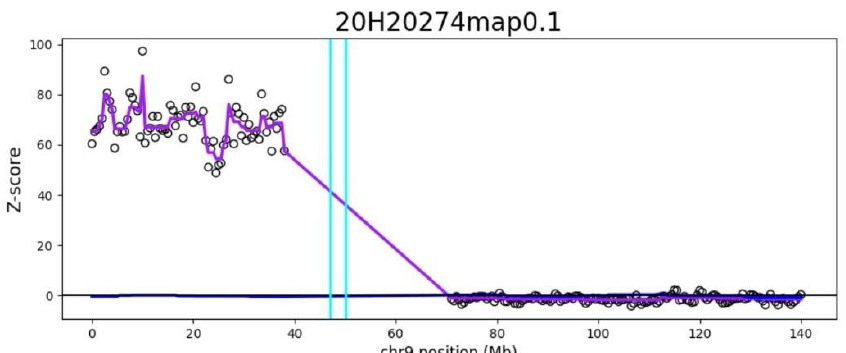
Figure 2. Detection of increased counts of DNA originating from chromosome 9p by genome-wide cfDNA screening post-delivery day 6. The genomic position is shown on the x-axis and the count- based z-score is shown on the y-axis. Each open circle on the plot represents a 1-Mb window. The light blue–green vertical lines mark the boundaries of the centromere. Genome-wide cfDNA screening results: increased DNA from 9p24.3-p13.1:1-38 500 000, count-based z-score of 70.